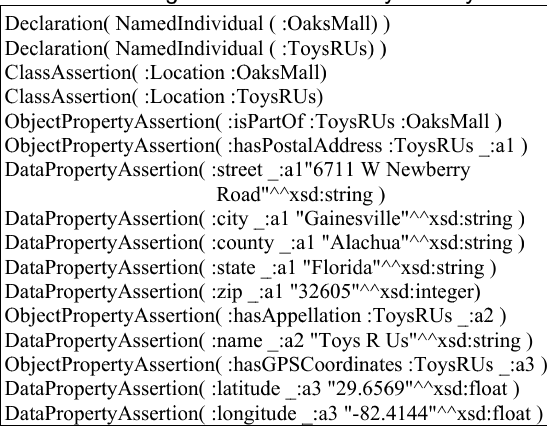
. An example location for An example location for Oaks Mall Oaks Mall location location location location location location location